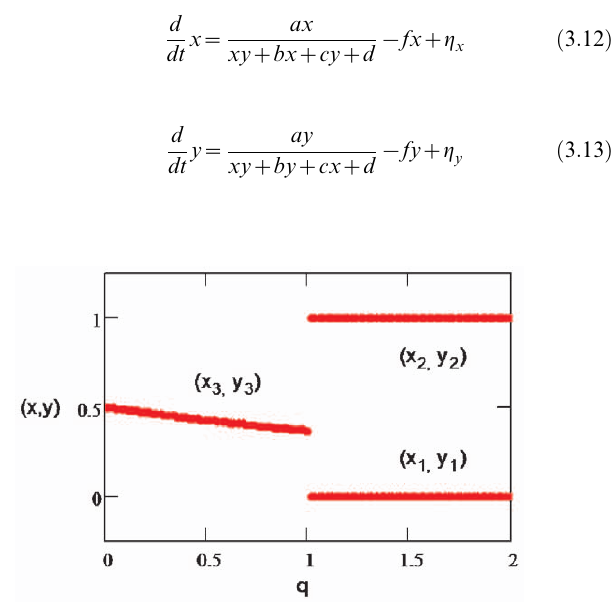
Figure 2. The bifurcation of the system for the bifurcation parameter q=c/b . Values are as follows: a = f =1, d = b =0.5 and 0 ƒ q ~ c = b ƒ 2 . At the critical point q =1 when c , which is proportional to cross inhibition, becomes larger than b , the system bifurcates from one stable ( x 3 , y 3 ) two to stable steady states ( x 1 , y 1 ) and ( x 2 , y 2 ) (solid lines).